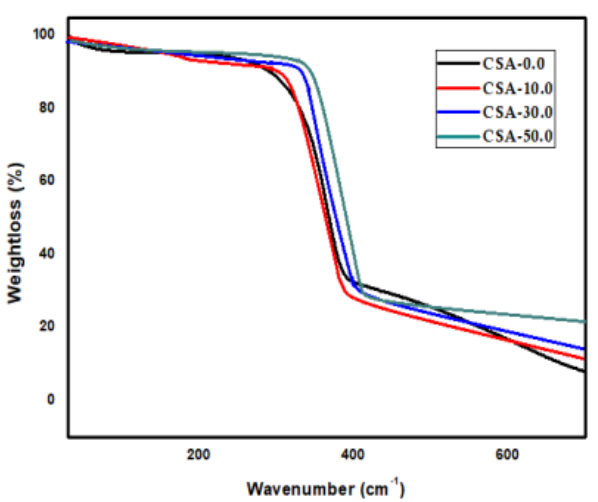
Figure 3. TGA curves of chitosan, and chitosan/almond gum composite